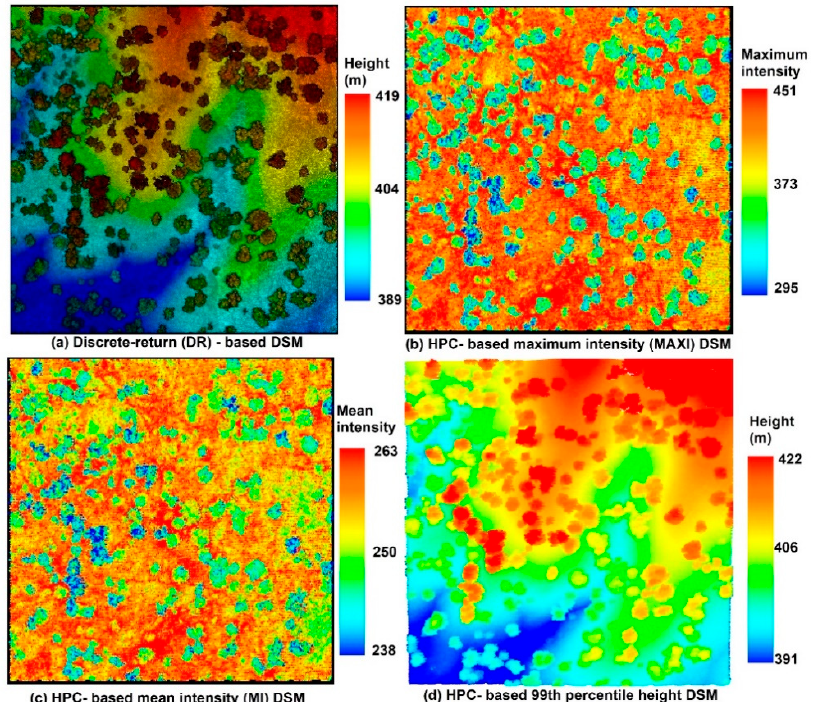
Figure 7. Comparisons of ( a ) the discrete-return (DR)-based digital surface model (DSM) with three products from waveformgrid function: ( b ) the HPC-based MAXI DSM, ( c ) HPC-based MI DSM and ( d ) HPC-based 99th percentile height (PH) DSM from the hyper point cloud (HPC) [14] .